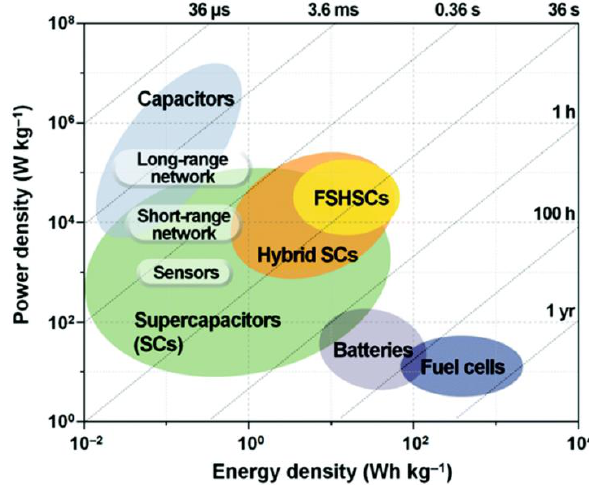
Figure 12. A Ragone plot of the specific energy and power densities of various energy storage devices. Reproduced with permission [7] Copyright © 2022, Energy & Environmental Science.